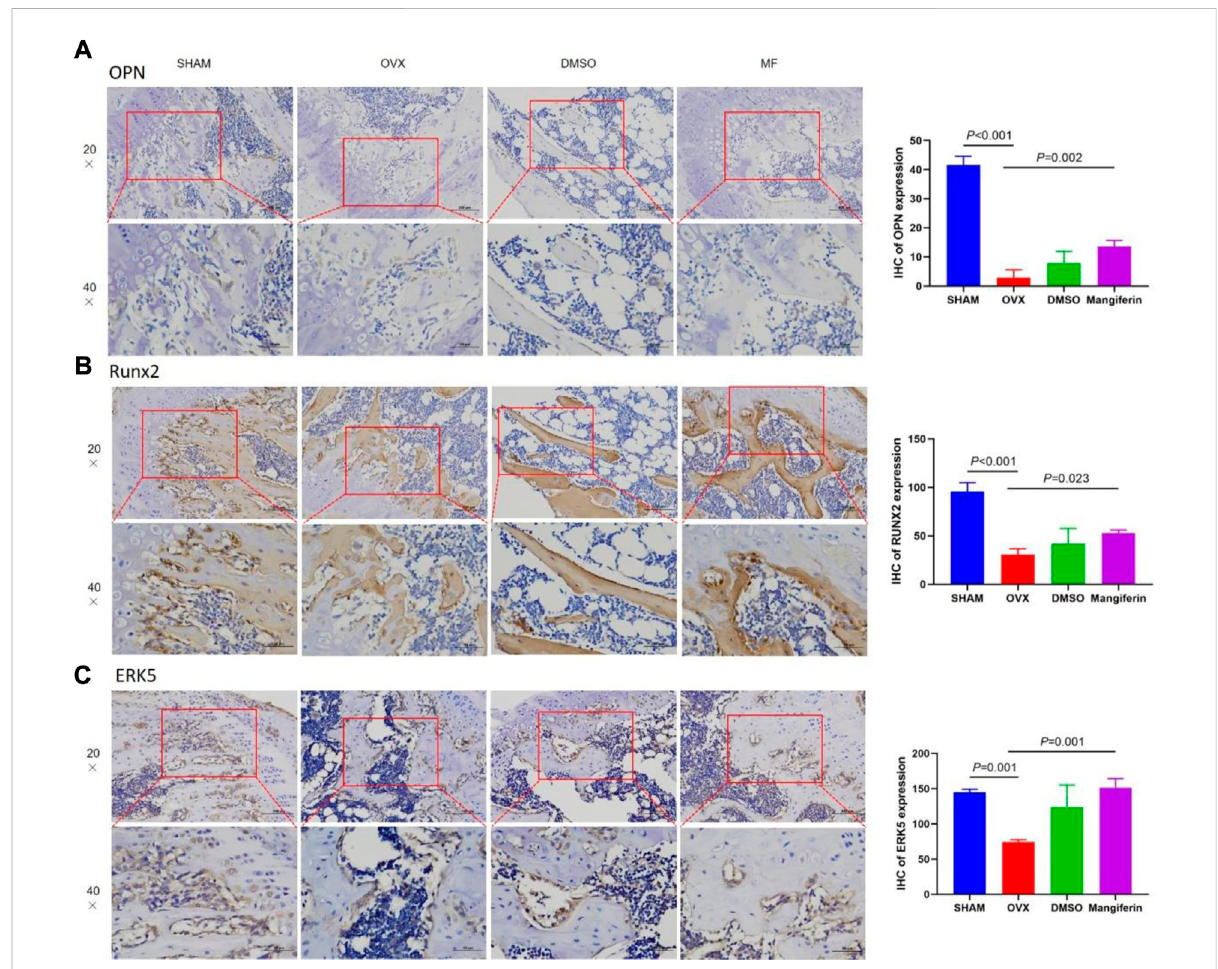
FIGURE 8 IHC of the femur, in the SHAM, OVX, DMSO, and mangiferin group. The levels of OPN (A) , RUNX2 (B) , and ERK5 (C) the OVX group signi fi cantly decreased when compared with the SHAM group ( p < 0.01, respectively), while they signi fi cantly increased in the mangiferin group when compared with the OVX group ( p < 0.05,